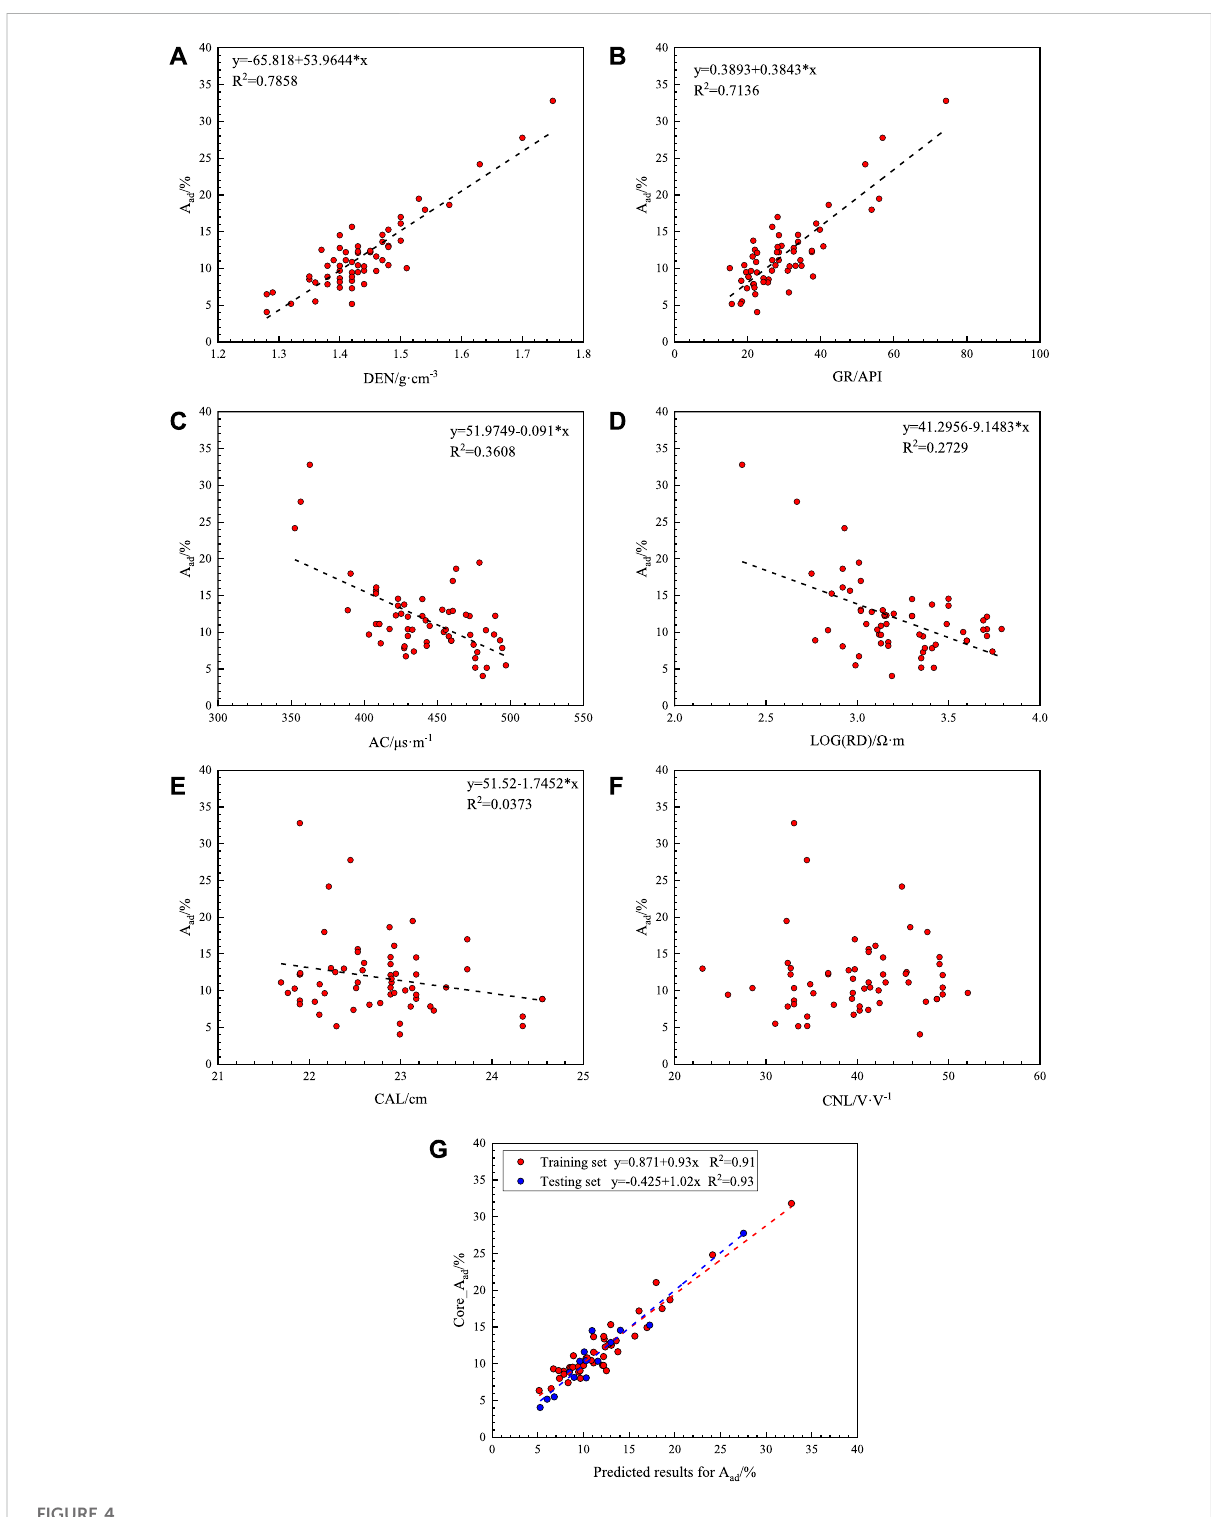
FIGURE 4 Correlation analysis oftheA ad contentandthegeophysical loggingdata response withthepredictedresults oftheA ad content. (A) Relationship between the A ad content and DEN. (B) Relationship between the A ad content and GR. (C) Relationship between the A ad content and AC. (D) Relationship between theA ad content andRD. (E) RelationshipbetweentheA ad contentand CAL. (F) RelationshipbetweentheA ad contentandCNL. (G) Performance of the OBGM (1, 5) prediction model on the training and test sets for the A ad